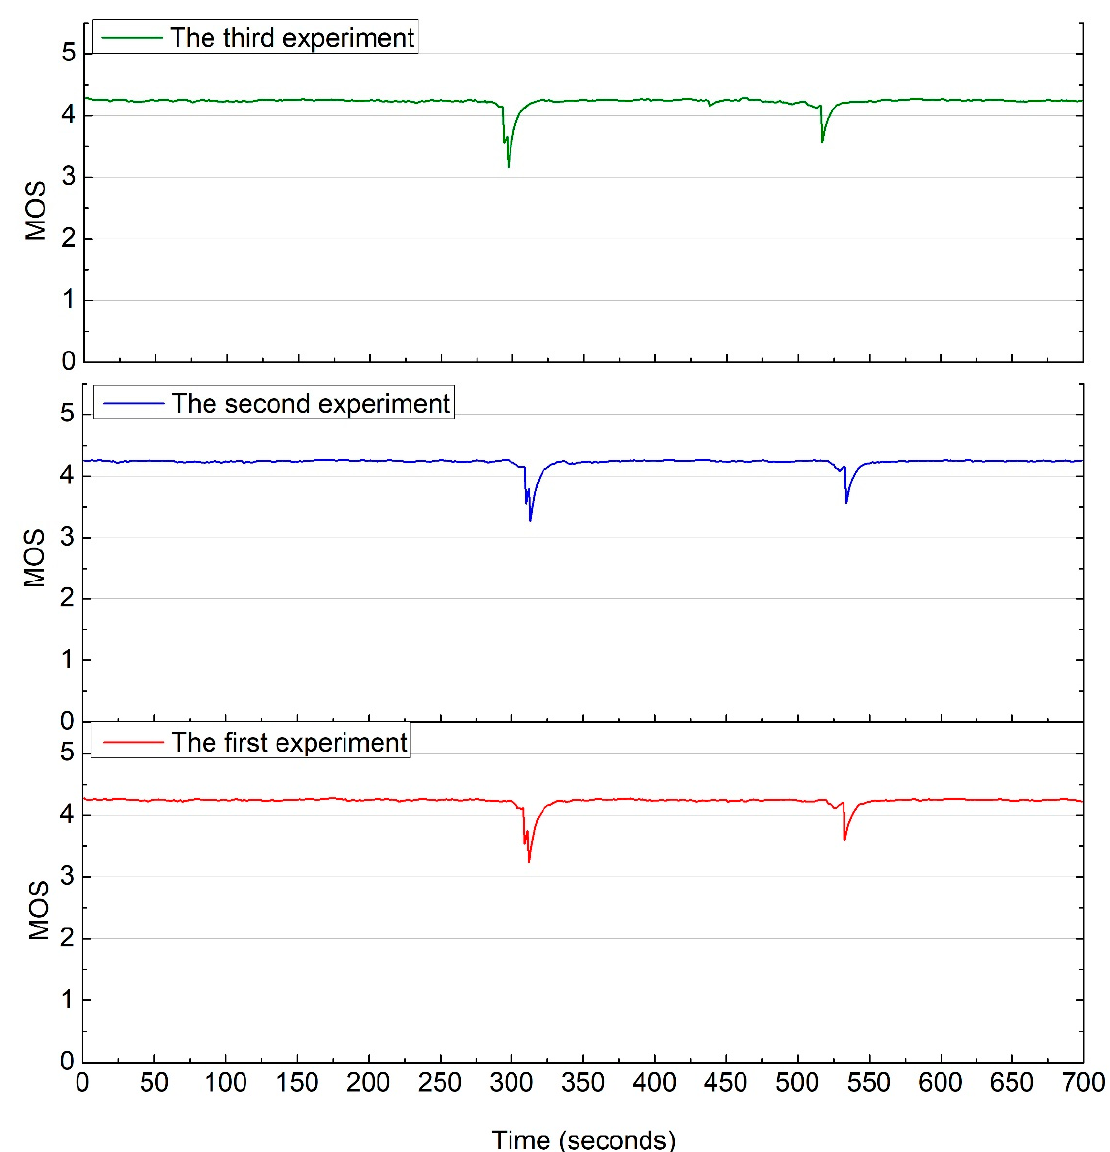
Figure 25. Figure 25. The MOS of three experimental results of the proposed deep-learning-based handover mechanism.